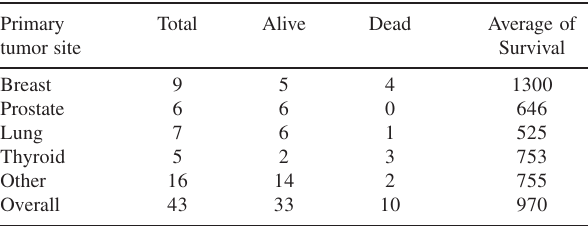
Table 4- Days of survival by primary tumor site